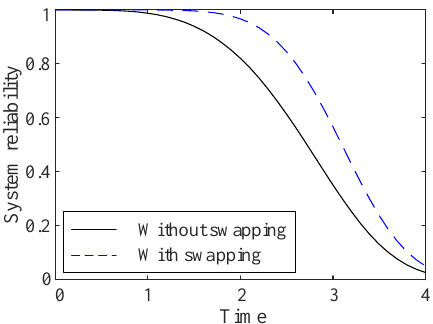
Figure 5. Reliability curves of the system considering